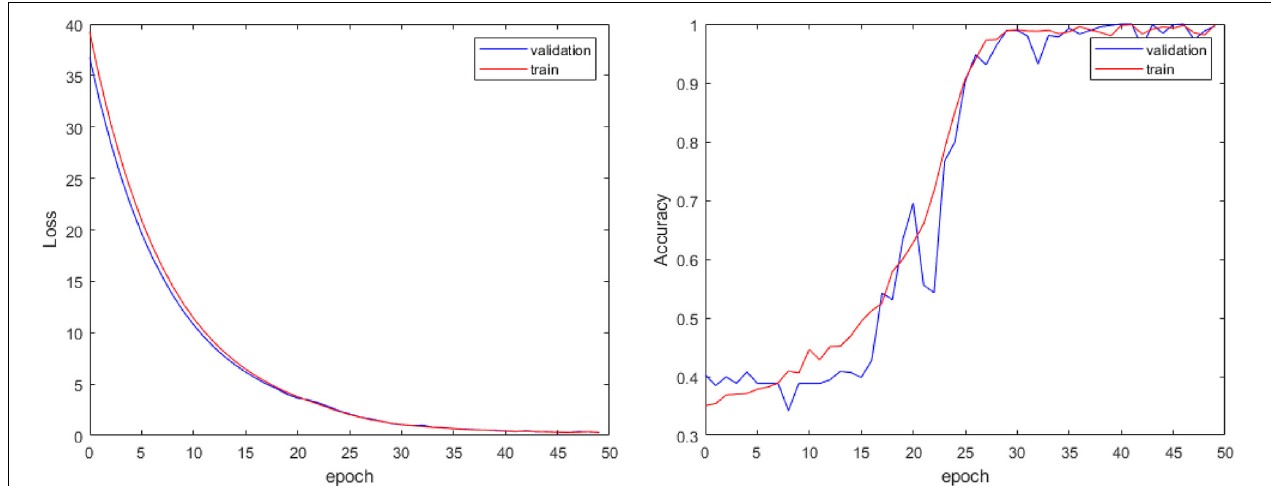
FIGURE 4 | Loss curve and accuracy curve of our